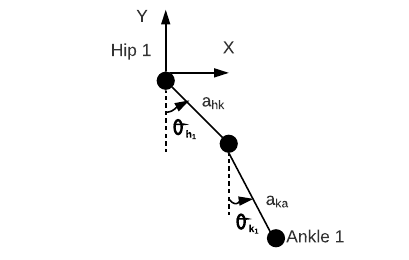
Figure 3. The right leg from the side view in a schematic way. a hk corresponds to a length between the hip and the knee. a ka is a length between the knee and ankle. Both of the angles are defined as positive in counterclockwise